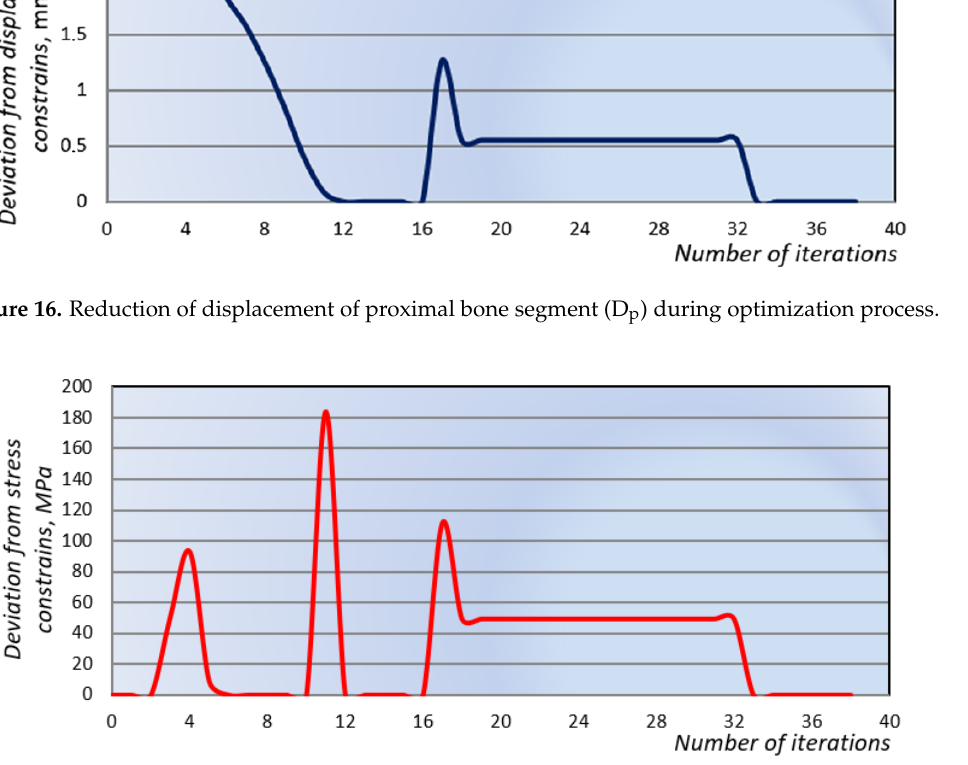
Figure 17. Difference between calculated and allowed von Mises stresses ( σ vm − ) at fixator tree during Figure 17. the optimization process.